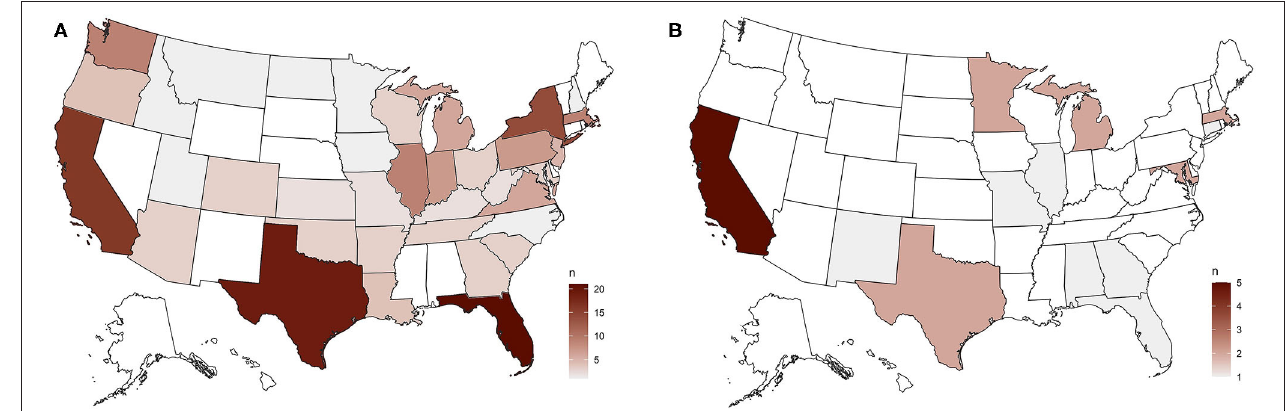
FIGURE 2 | (A) Organizations reporting that feral cat advocates and animal control authorities involved in active collaboration were distributed similarly to our overall sample. (B) Organizations reporting public/overt conflict between feral cat advocates and animal control authorities, with the greatest number from California.